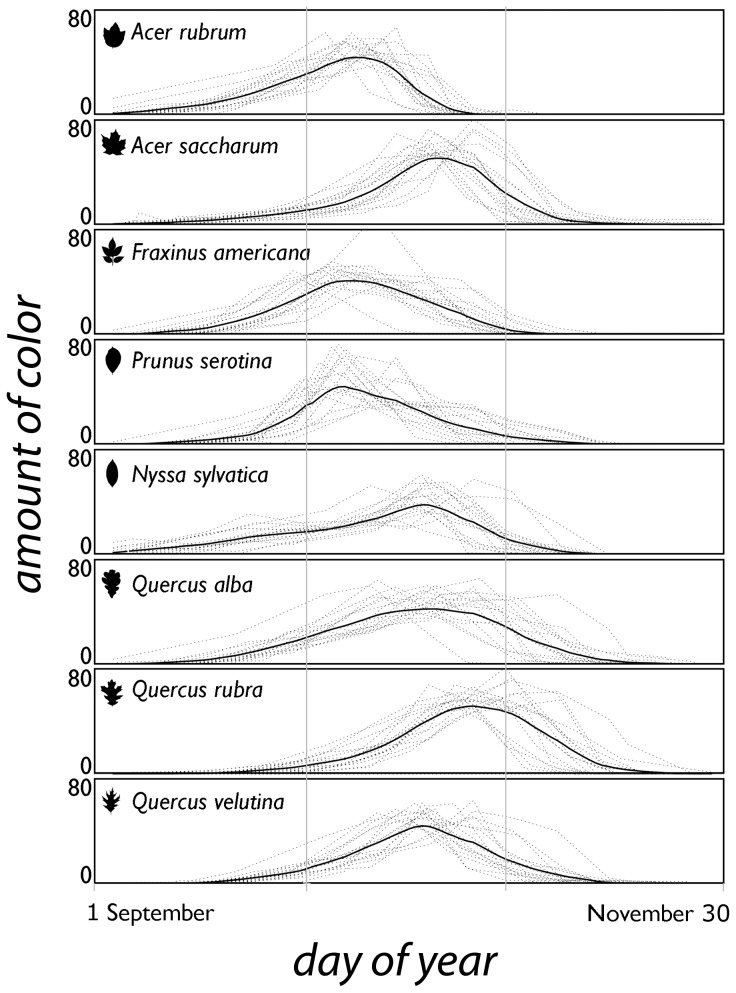
The amount of autumn colors over time for eight deciduous broadleaf species that turn red in autumn.The amount of autumn color (0–100) is calculated as i
n(100−j
n) on day n, where the percentage of red leaves i
n is multiplied by the percentage of leaves retained (100−j
n). Individual years (1993–2010) are shown by dotted lines, and their average by the thick curve.